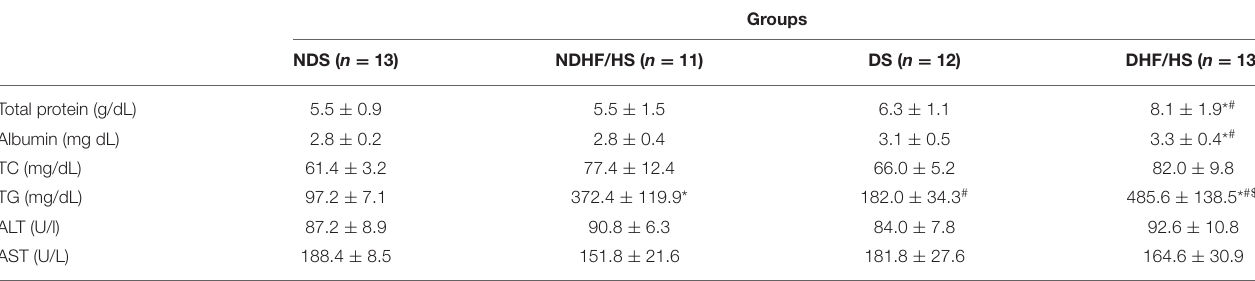
TABLE 3 | Biochemistry parameters at term pregnancy of non-diabetic (ND) and diabetic (D) rats treated or not (S) with high-fat/high-sugar diet (HF/HS) before and during pregnancy.